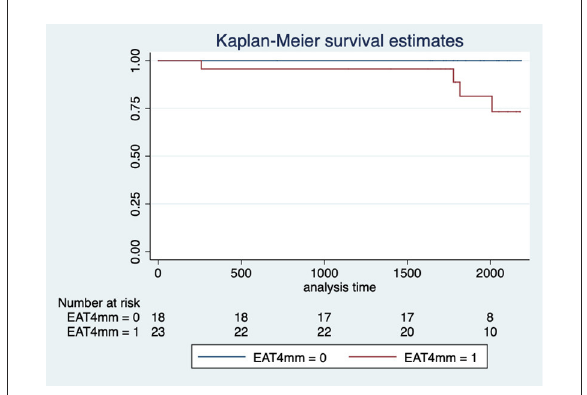
FIGURE2 Kaplan-Meier curve of MACE after a MI by the thickness of EAT. EAT, Epicardial Adipose Tissue; MI, Myocardial